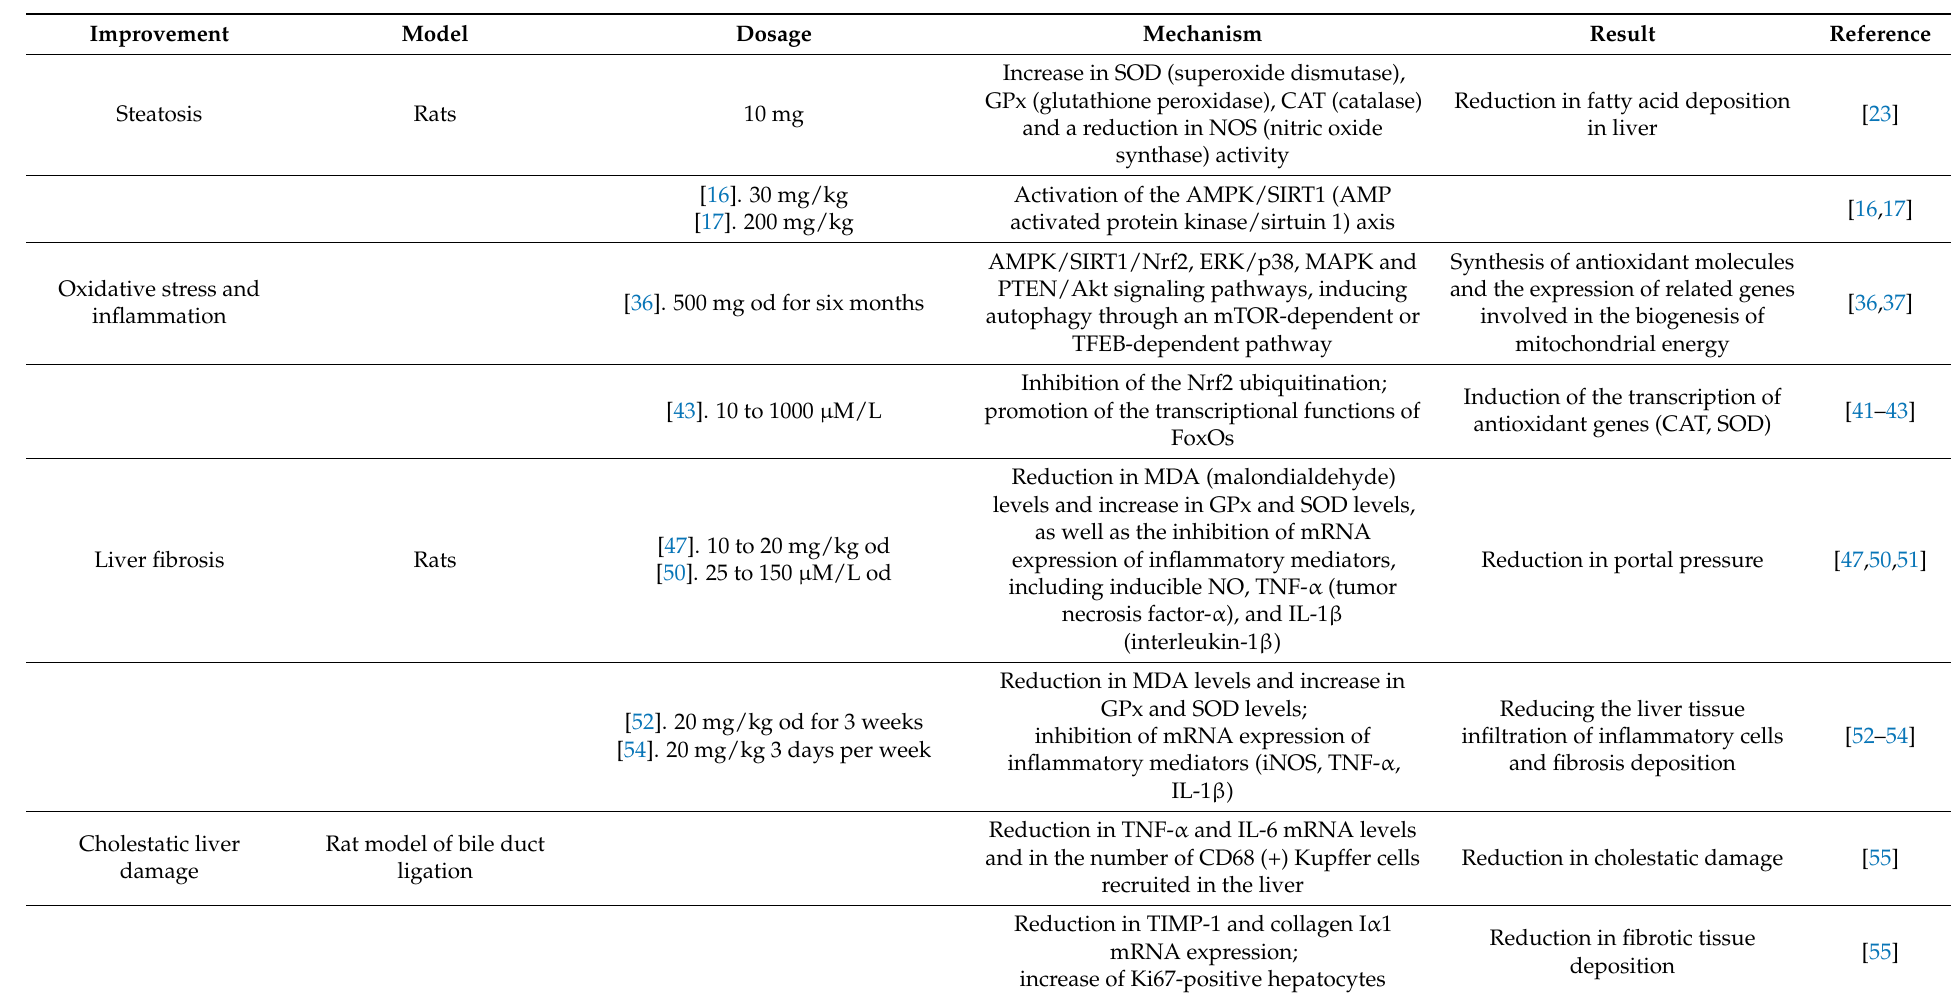
Table 1. Summary results of the intervention studies of Resveratrol in different